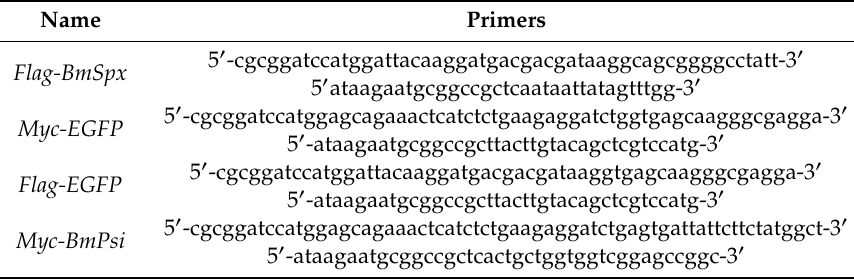
Table 2. Primer sequences of vector